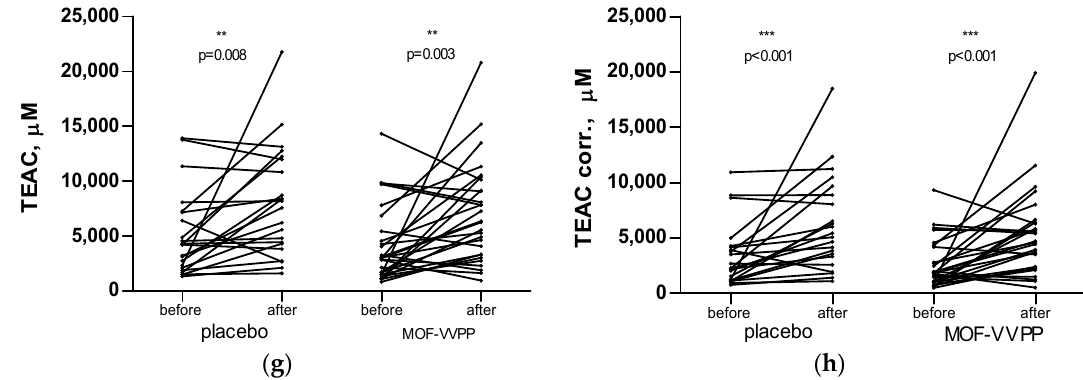
Figure 3. Changes in urinary neutrophil gelatinase-associated lipocalin, uNGAL ( a ), interleukin (IL)-6 ( b ), IL-8 ( c ), tumor necrosis factor (TNF)- α ( d ), IL-18 ( e ), malondialdehyde, MDA ( f ), trolox-equivalent antioxidant capacity, TEAC ( g ) and TEAC corrected for uric acid TEACcorr. ( h ) in the urine. * p < 0.05, ** p < 0.01, *** p < 0.001. Data are presented in absolute values as symbols and lines. Urine samples were obtained before and after the use of a 400-mg single-dose ibuprofen followed by the completion of the half-marathon. Within-group changes were assessed by the Wilcoxon matched-pairs signed rank test, and between-group changes were tested by the Mann-Whitney U test.